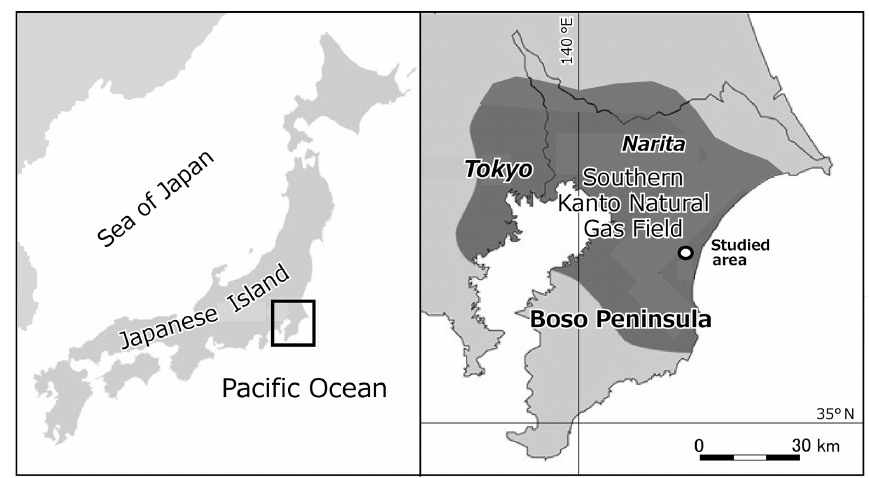
Figure 1. The Southern Kanto gas field (modified Ikeda et al., 2015, based on AIST, 2015).